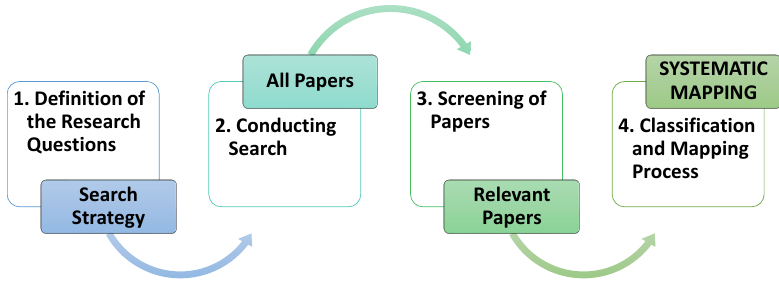
Figure 1. Systematic mapping